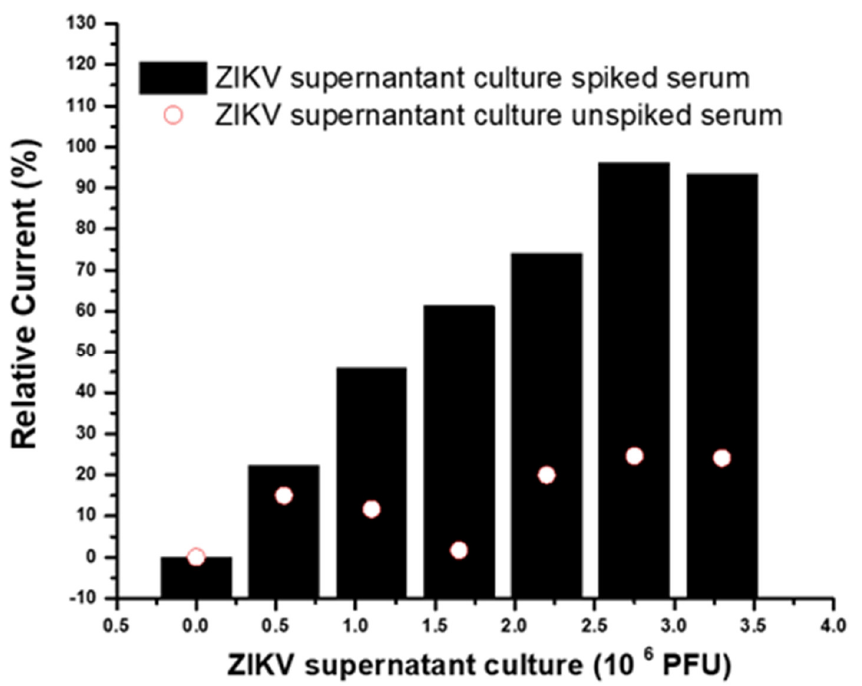
Figure 8. Immunosensor response to successive incubations with serum samples spiked and unspiked with ZIKV supernatant culture.